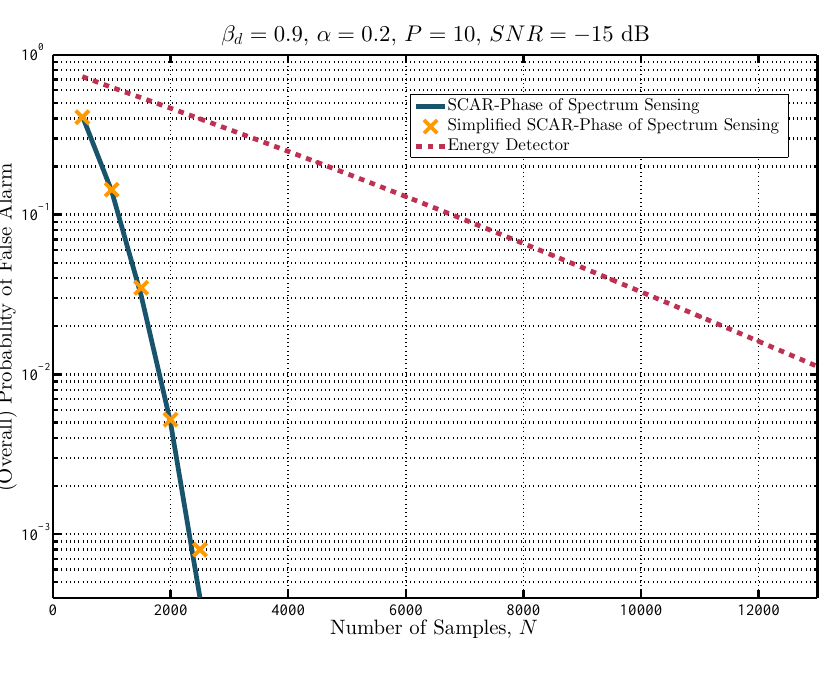
Figure 10. Probability of false alarm against sensing